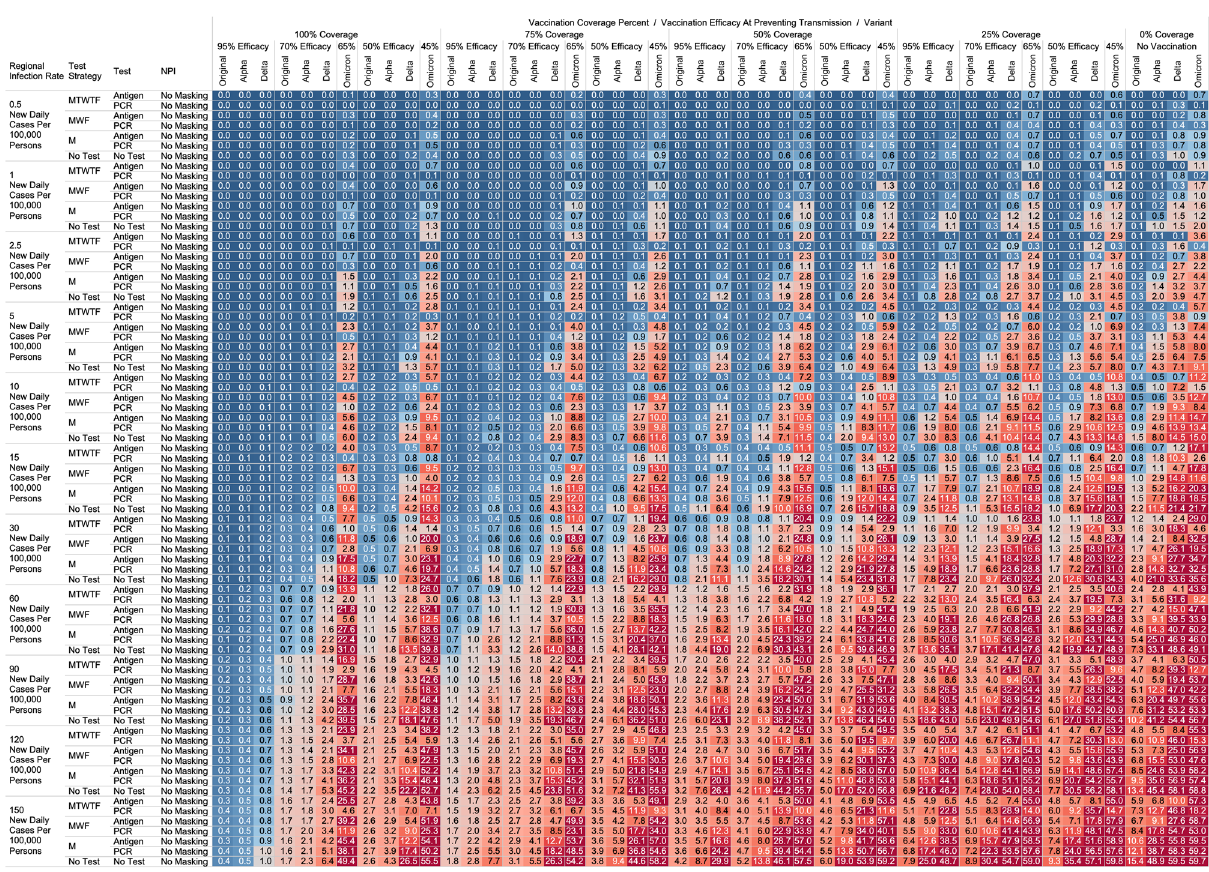
tests a variant specific as outlined in Table